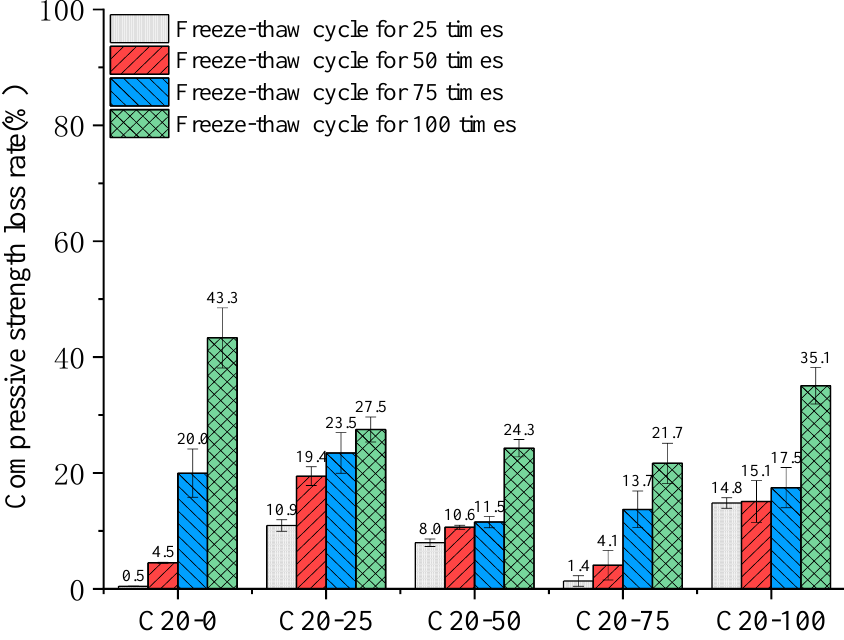
Figure 12. Loss rate of compressive strength of C20 concrete under freeze – thaw cycles.